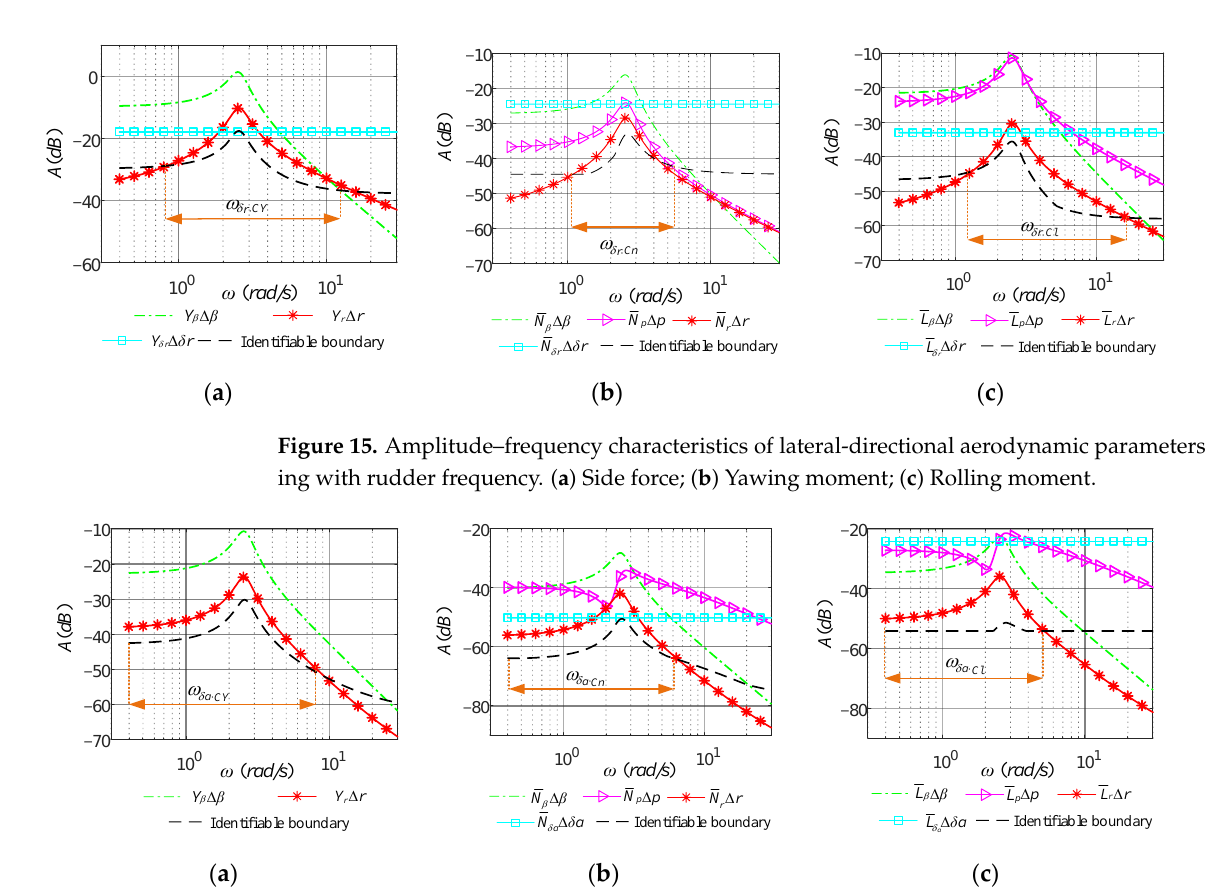
Figure 17. Lateral-directional excitation signal. 5.3. Identification Results of Aerodynamic Derivatives 5.3.1. Identification of Side Force Derivatives The wind tunnel virtual flight test is carried out under the conditions of V = 30 m/s, α = 6°, β = 0°, and δ e = −5.6°. The outer ring of the flight control law is the instruction of 0° sideslip angle and 0° roll angle. The excitation signal is directly input on the V-tail control